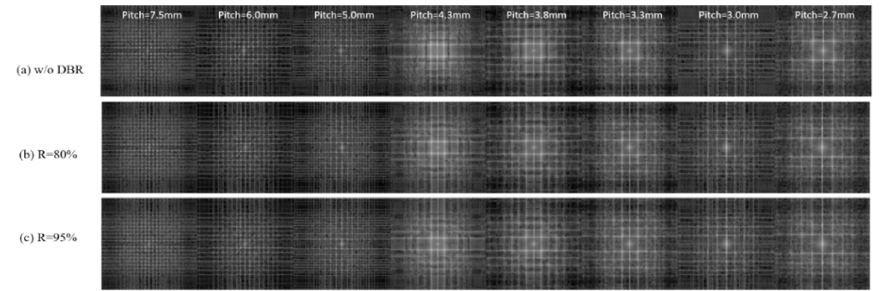
Figure 5. Fourier image of mini light-emitting diode module (a) without (b,c) with the DBR.